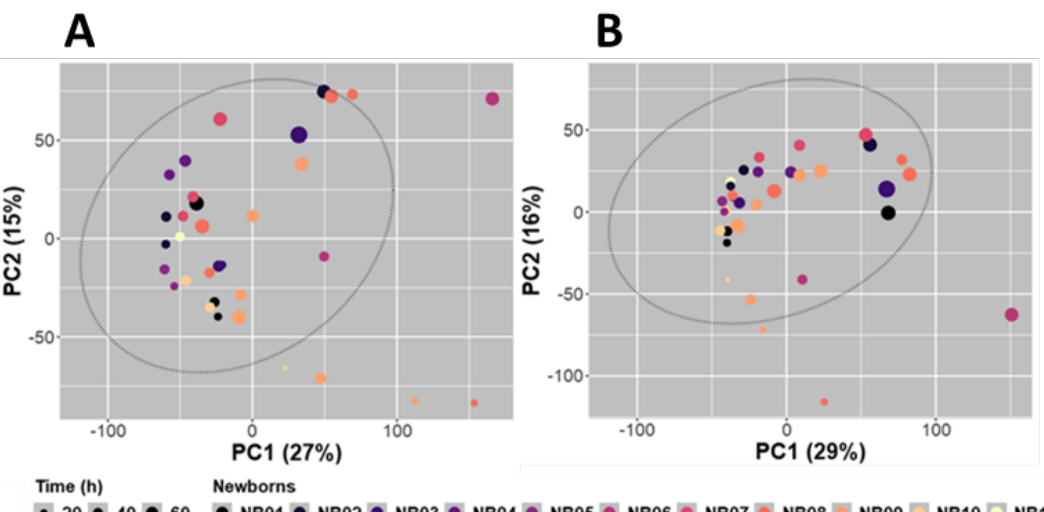
Figure 3. PCA scores plot (PC1 vs. PC2) built using all relevant features obtained in C18-ESI + (( A ) 8555 features) and HILIC-ESI − (( B ) 6843 features) MS detection conditions. The colors used represent the different newborns (NB01 to NB11) the meconium samples were collected from. The size of each point traduces the collection time-points, expressed in hours (h). Data were log10-transformed and mean-centered before PCA. Ellipses represent the confidence intervals of the scores projected on factorial plans at a probability p = 0.975.